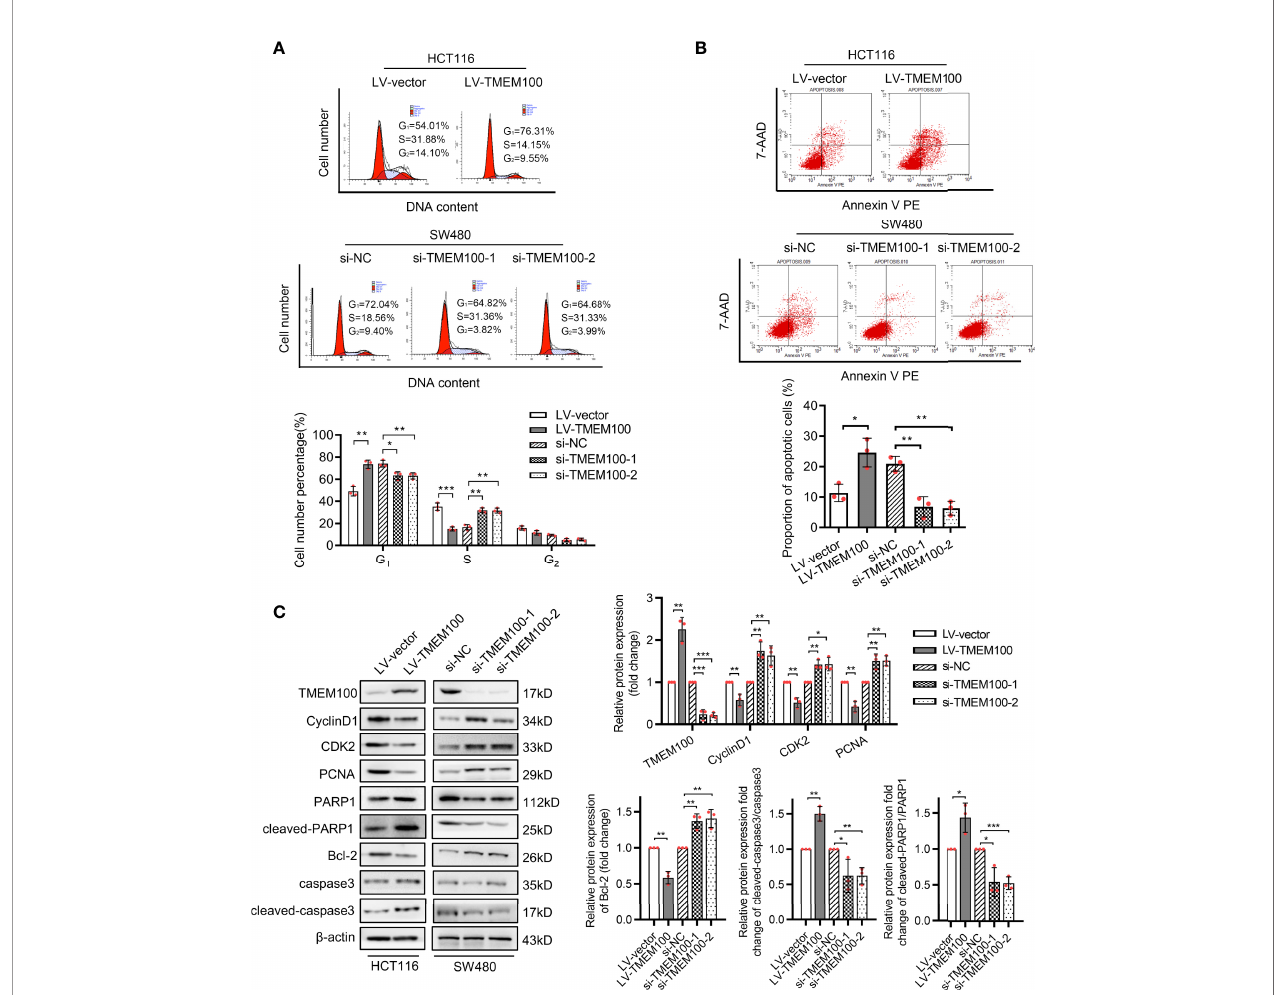
FIGURE 3 | TMEM100 arresting cell cycle and potentiating apoptosis of CRC cells. (A) The representative pictures of the distribution of different cell cycle phases in indicated cells by fl ow cytometry. The percentage of cells in different phase of cell cycle was analyzed. Two-sided t-test. (B) The representative pictures of the percentage of cells undergoing apoptosis by fl ow cytometry in indicated cells. Two-sided t-test. (C) Western blotting analysis of TMEM100, CycilnD1, CDK2, PCNA, PARP1, cleaved-PARP1, Bcl-2, caspase3 and cleaved-caspase3 expression in indicated cells. b -actin was used as a reference control. Two-sided t-test. Data are presented as the mean ± SD. * p <0.05, ** p <0.01, *** p